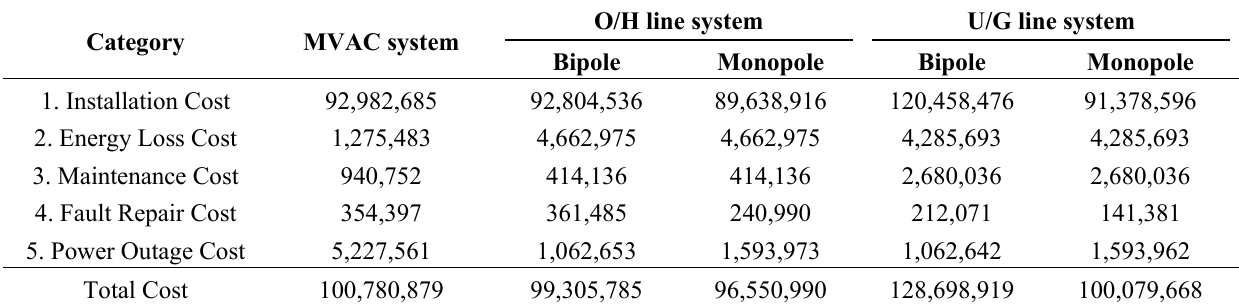
Table 13. NPV analysis for first year.